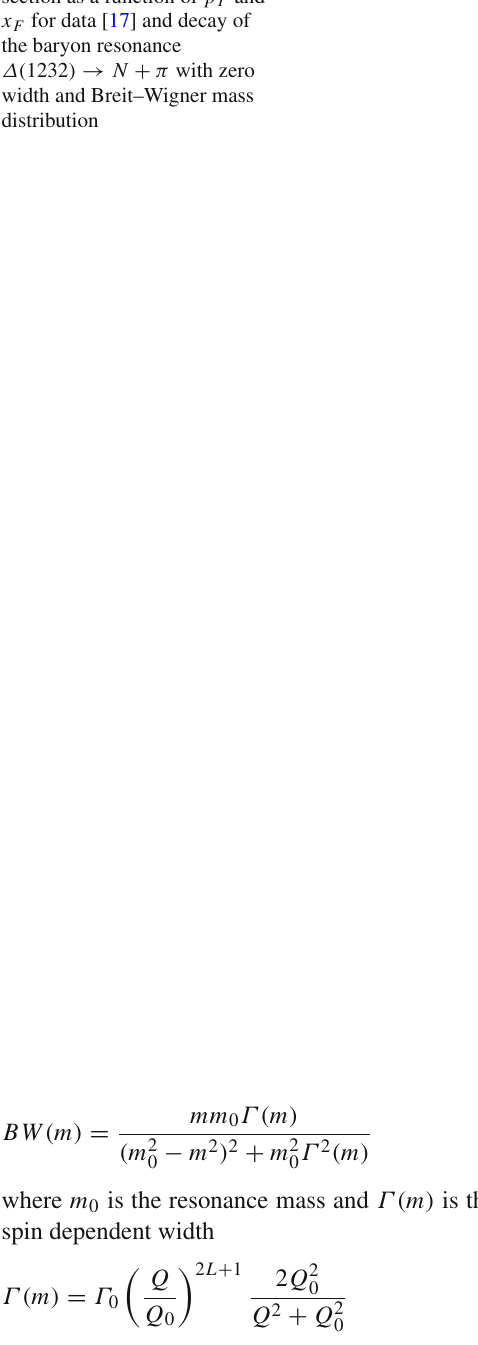
Fig. 158 Invariant pion cross section as a function of p T and x F for data [17] and decay of the baryon resonance Δ( 1232 ) → N + π with zero width and Breit–Wigner mass